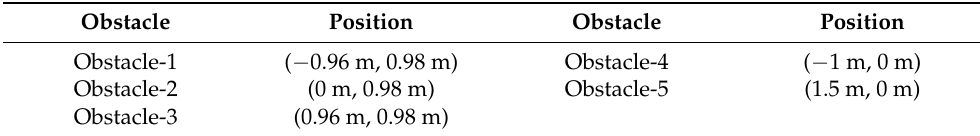
Table 2. Specific positions of obstacles.